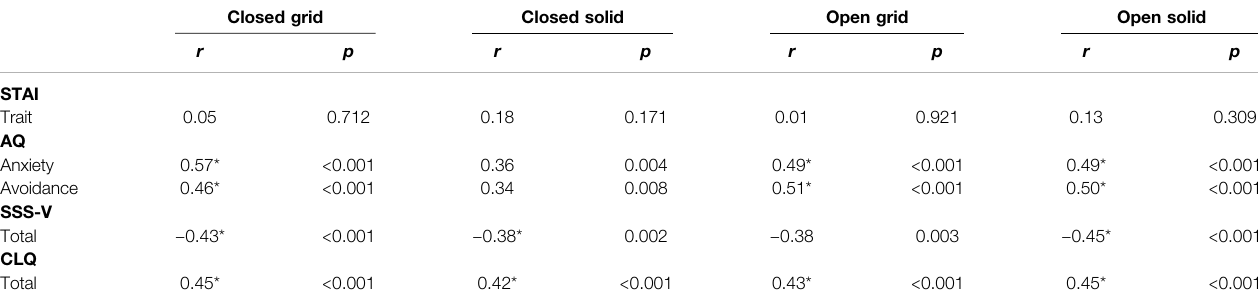
TABLE 6 | Results of correlation analyses of anxiety ratings on various EPM arms with psychometric questionnaires in study 2. Closed grid Closed